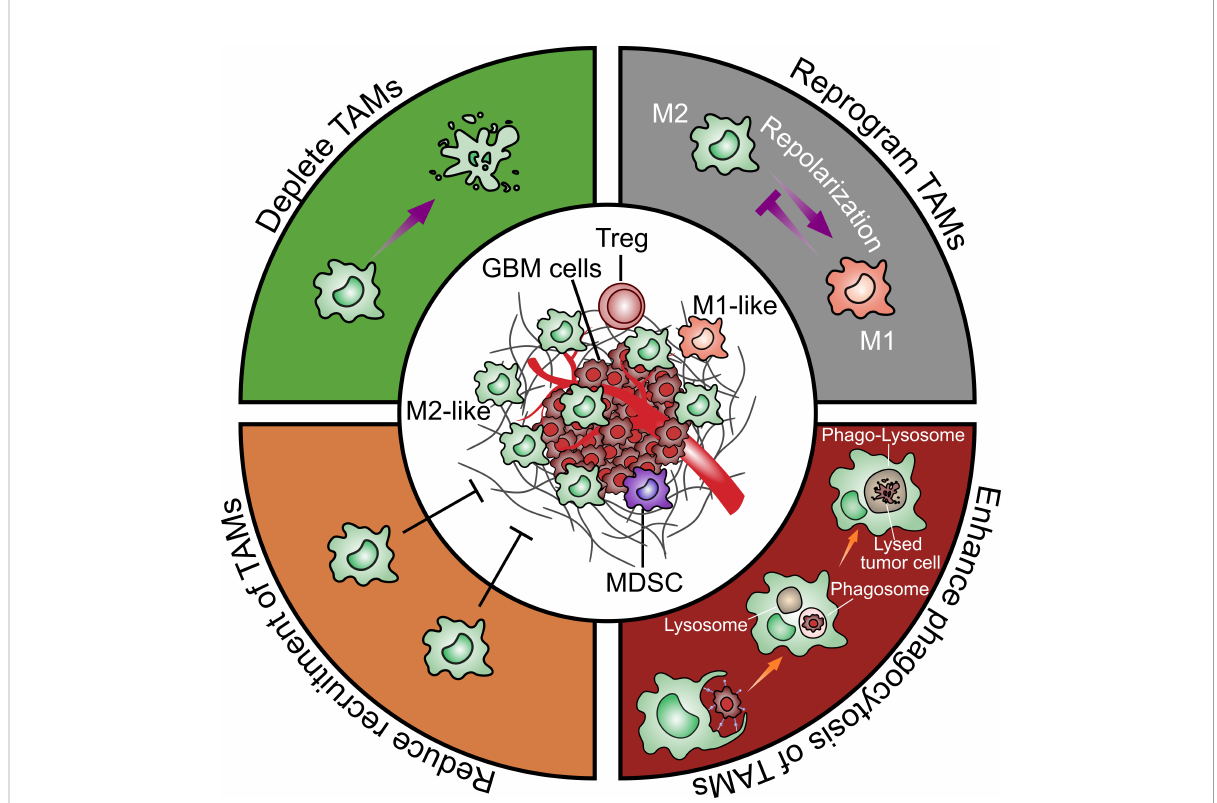
FIGURE 4 Strategies to target glioblastoma-associated microglia and macrophages. There are four general therapeutic strategies to target or utilize TAMs in GBM treatment including 1) directly depleting TAMs; 2) reprograming TAMs from an M2-like pro-tumoral phenotype to an M1-like anti- tumoral phenotype; 3) enhancing TAMs phagocytosis on tumor cells; 4) reducing TAMs recruitment to the tumor